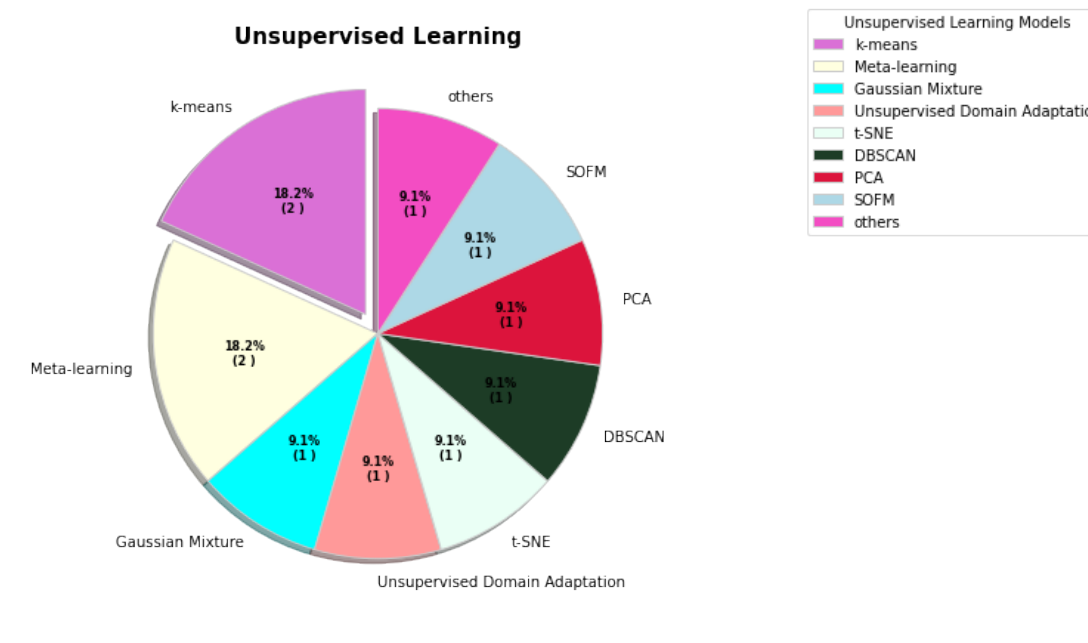
Figure 4. The percentages of various unsupervised learning models used for COVID-19. In unsupervised learning, Figure 4 indicates k-means and meta-learning reached 18.2%. However, gaussian mixture, unsupervised domain adaptation, t-SNE, DBSCAN, PCA, SOFM, and other models contributed